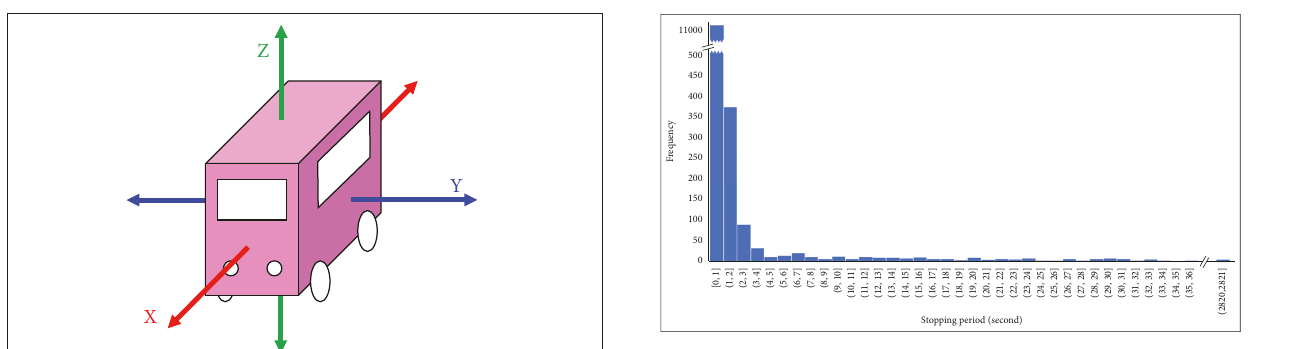
Figure 6: Histogram of inactive